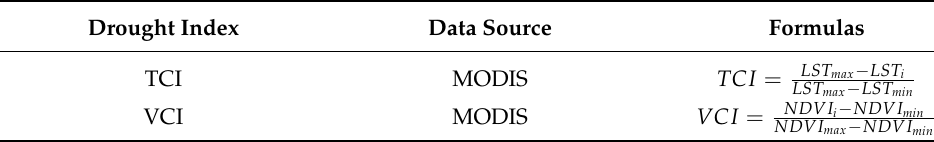
Table 3. Calculation formula of single factor drought index. Drought Index